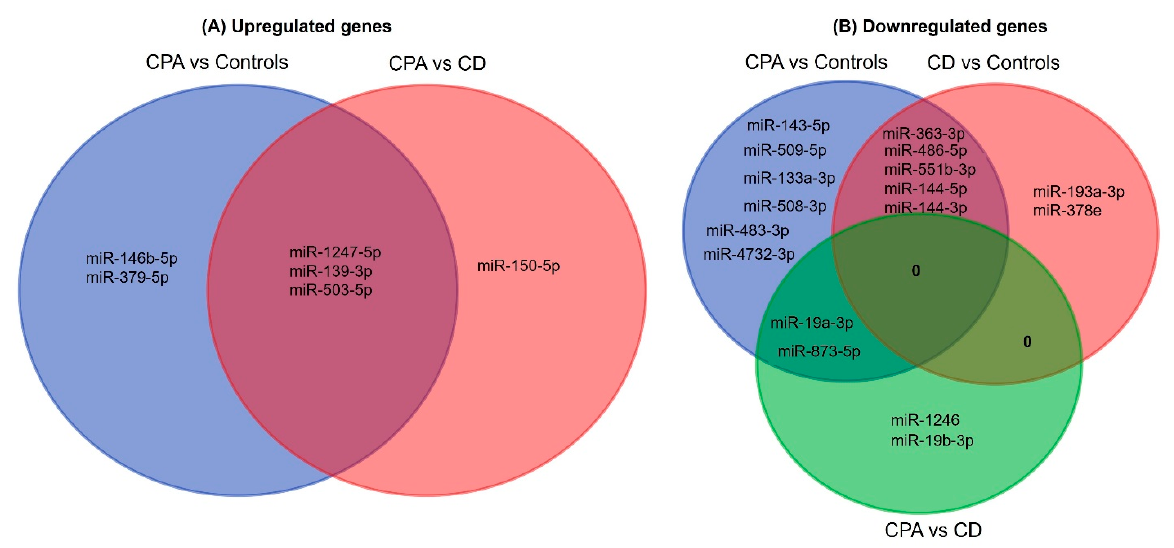
Figure 2. Venn analyses of the common significant miRNAs from each group. The significantly expressed miRNAs from each sequencing analysis were shortlisted and compared between the groups. CPA, cortisol producing adenoma; CD, Cushing’s disease.